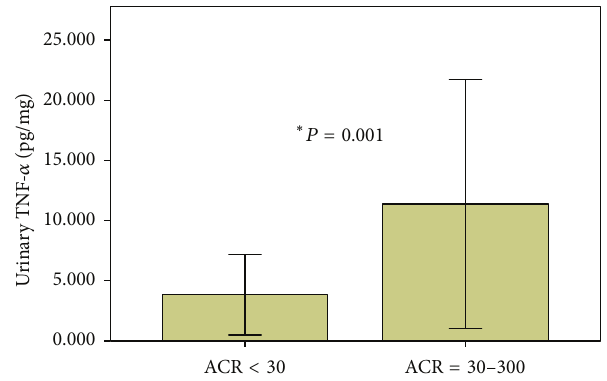
Figure 2: TNF- 𝛼 urinary levels in diabetic patients with normoal- buminuria and